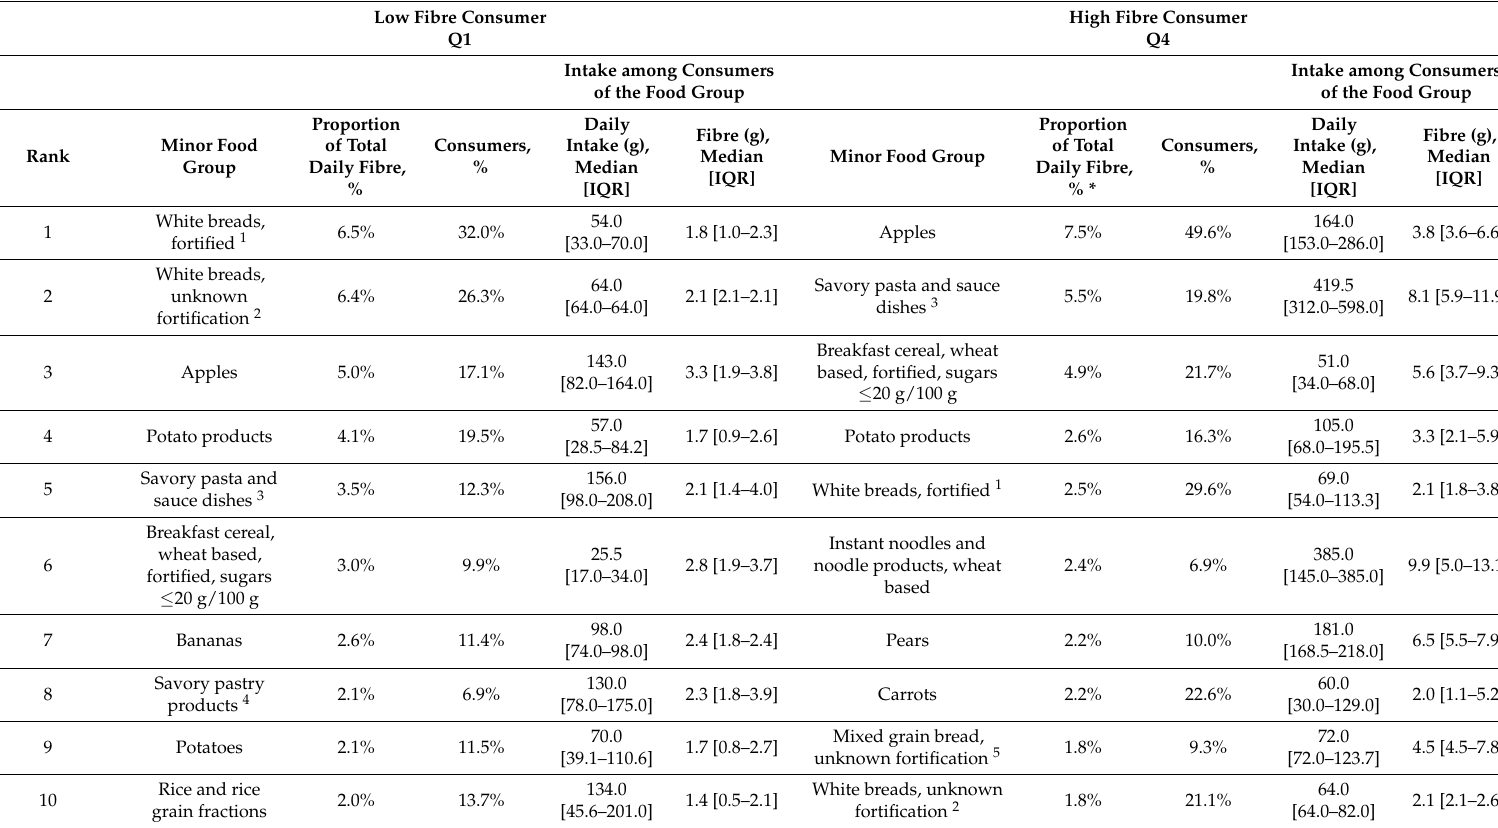
Table 5. Leading minor food groups by contribution to dietary fibre intake in children aged 2–18